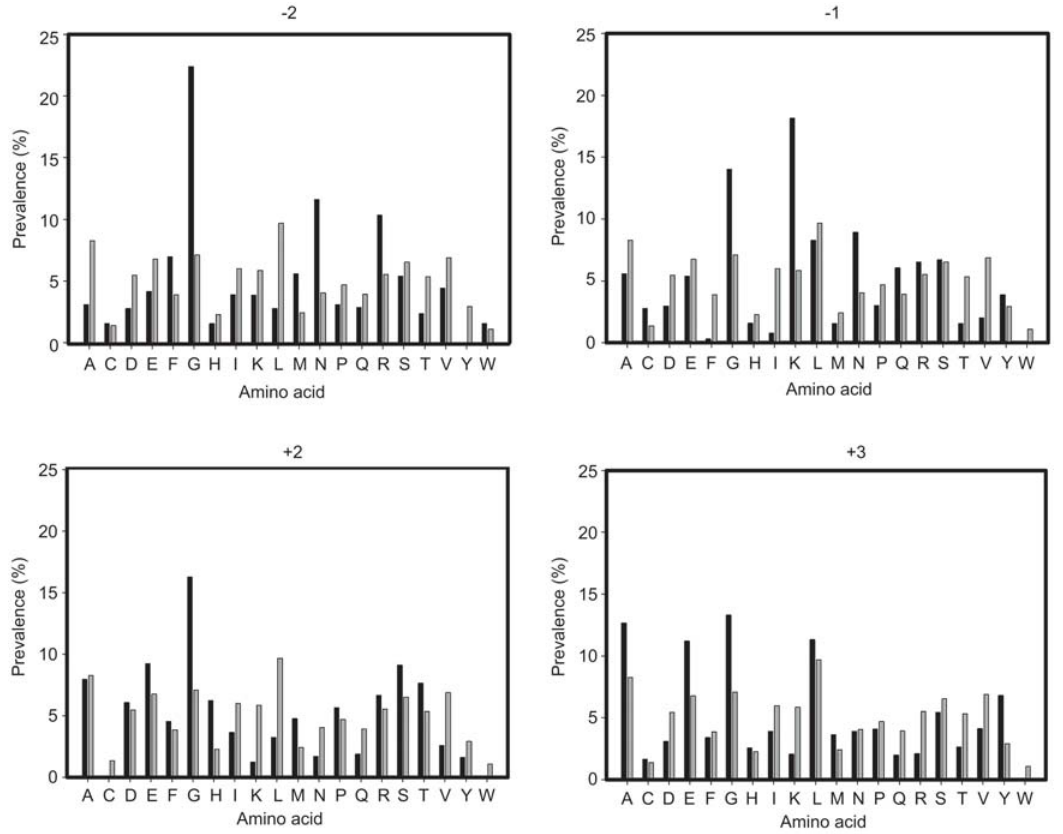
Figure 8 Conservation of intein junction sequences. Bar graph representation of sequence conservation at extein positions -2, -1, q 2, and q 3. All complete intein junction sequences (positions -2, -1, q 2 and q 3) were retrieved from Inbase w http://www.neb.com/neb/inteins.html, (12); 550 entries as of Nov 3, 2010 x . To prepare the bar graphs, the prevalence of each amino acid at the positions -2, -1, q 2, and q 3 was calculated (%), and values were plotted using Sigma Plot. Prevalence values for the average occurrence of each amino acid in proteins were taken from the UniProtKB/Swiss-Prot protein knowledgebase release 2011_02 statistics available online (http://au.expasy.org/sprot/relnotes/relstat.html). Black bars represent the amino acid prevalence of the extein residue indicated above the graph, grey bars represent the average amino acid prevalence in the protein knowledge